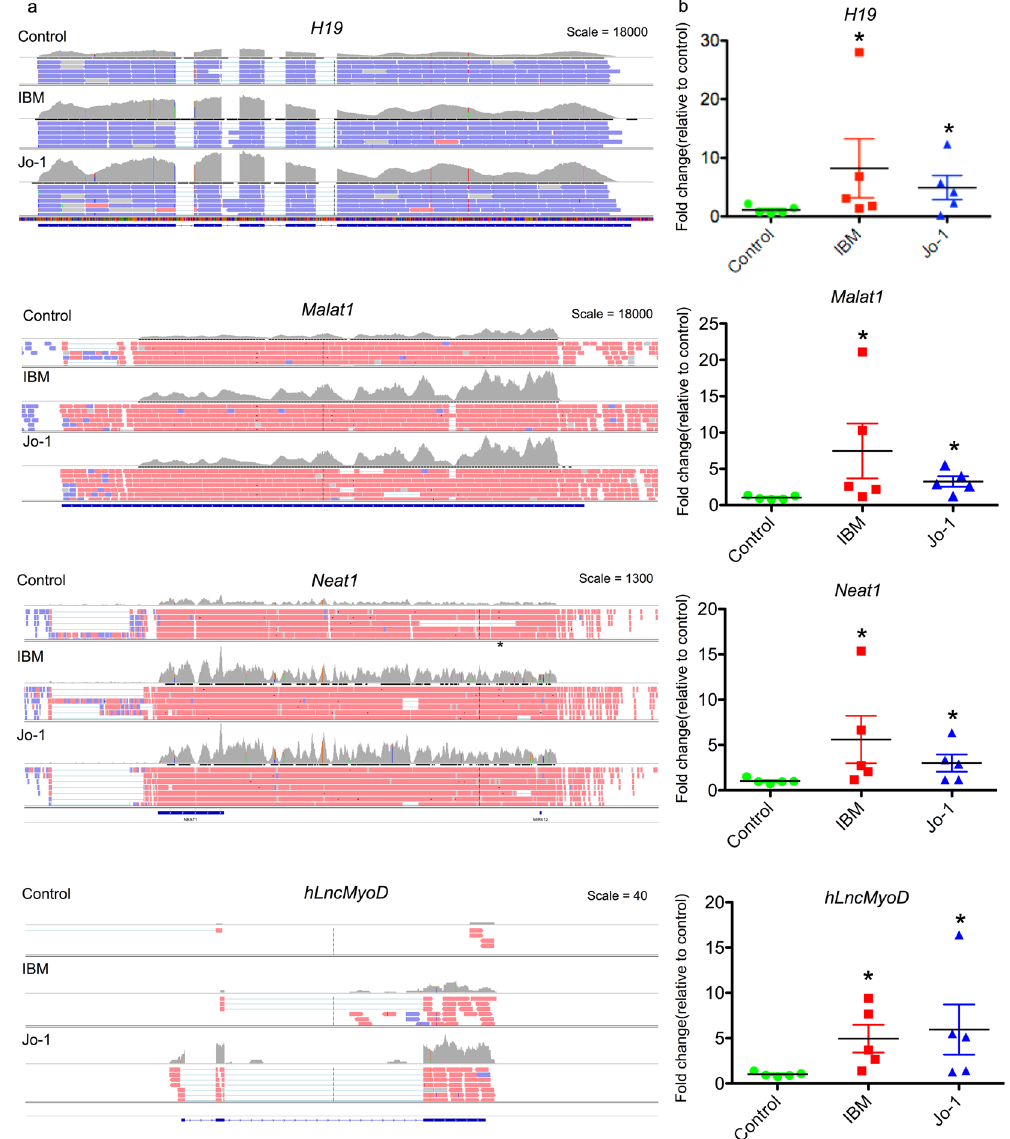
Figure 4. Differential expression of H19 , MALAT1 , NEAT1 and hLncMYoD in control, IBM and Jo-1 myositis. ( a ) View from the Integrated Genome Viewer (IGV) of aligned sequence data for H19 , MALAT1 , NEAT1 and hLncMYoD . Red and blue blocks represent reads aligned to the positive and negative strand of the DNA, respectively. The dark gray histogram represents the sum of the aligned sequencing reads along the genome, with the scale stated on the top right corner, ( b ) Changes in levels of H19 , MALAT1 , NEAT1 and hLncMYoD were confirmed using qRT-PCR the data are the mean ± SEM of 5 patients where * p < 0.05 (Mann-Whitney